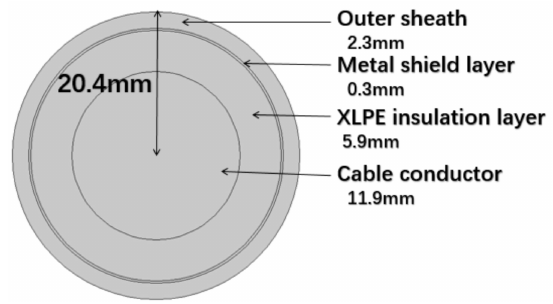
Figure 1. Schematic diagram of power cable